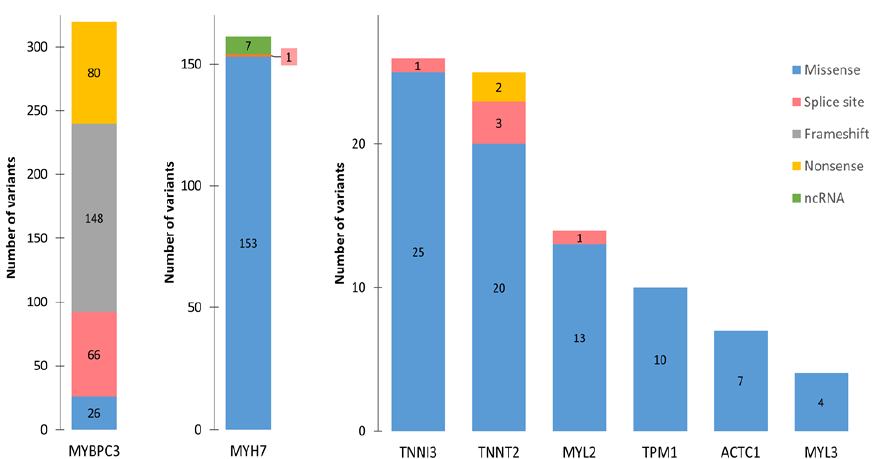
Figure 5. Hypertrophic cardiomyopathy (HCM) mutations. The bar graphs depict the number and type of HCM-associated variants in the indicated genes. All variants reported as pathogenic or likely pathogenic in the National Center for Biotechnology Information’s ClinVar database (http://www.ncbi.nlm.nih.gov/clinvar/) were considered.